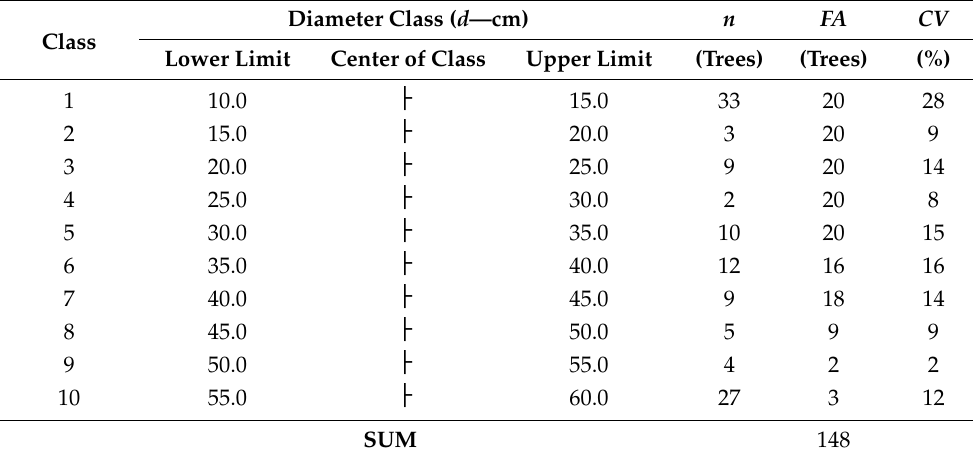
Table 3. Stratification proposed by the diameter class at breast height, by parameter class “ r ” and by artificial form factor class for Tectona grandis L.f. scaled trees, central-west region, Brazil .